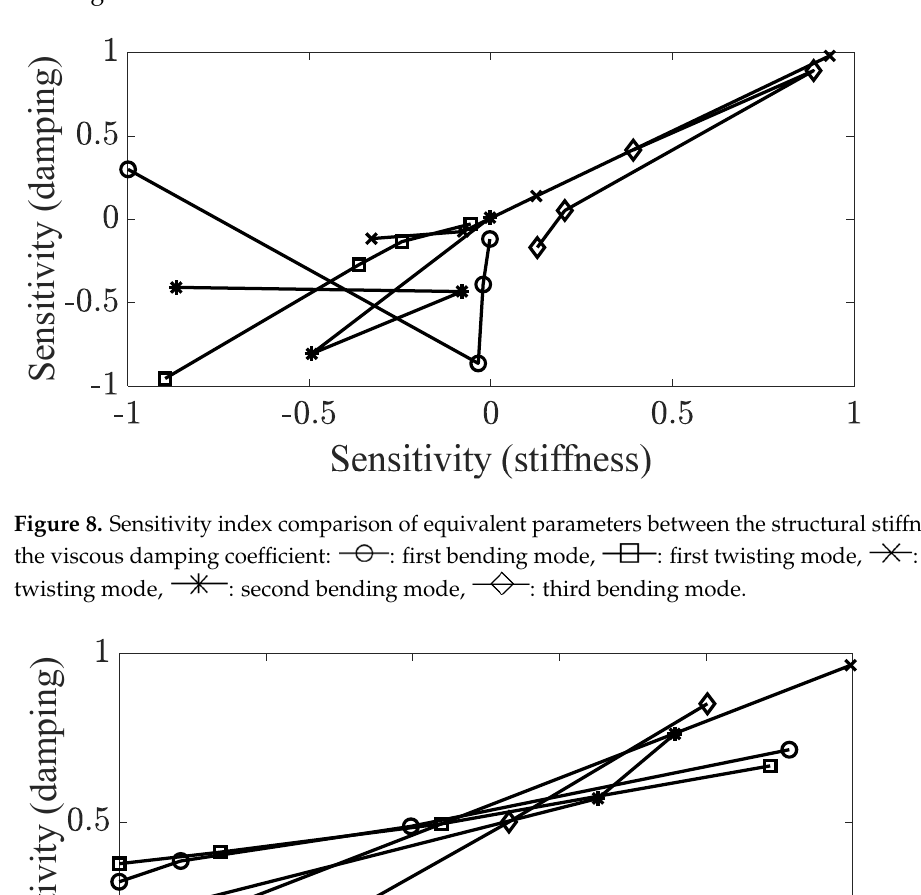
shown in Equation (20), the variation of equivalent viscous damping coefficient of CFRP